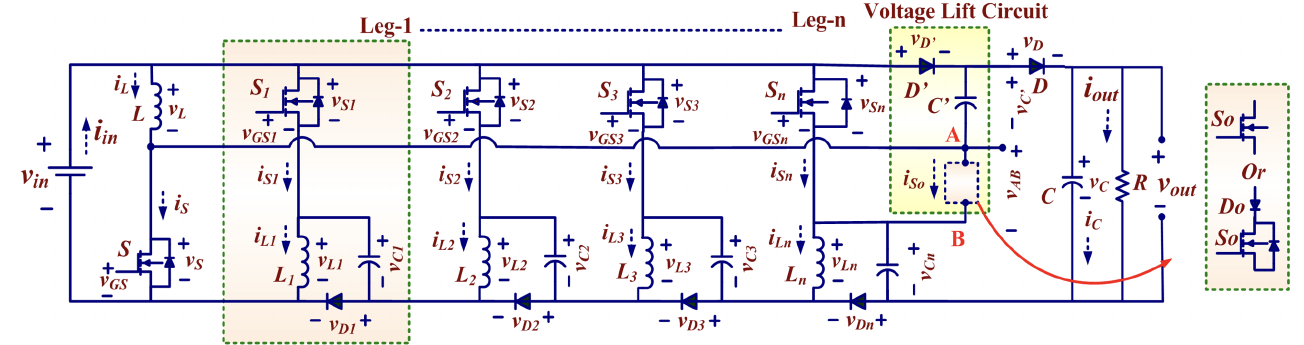
Figure 2. Power circuit of ML